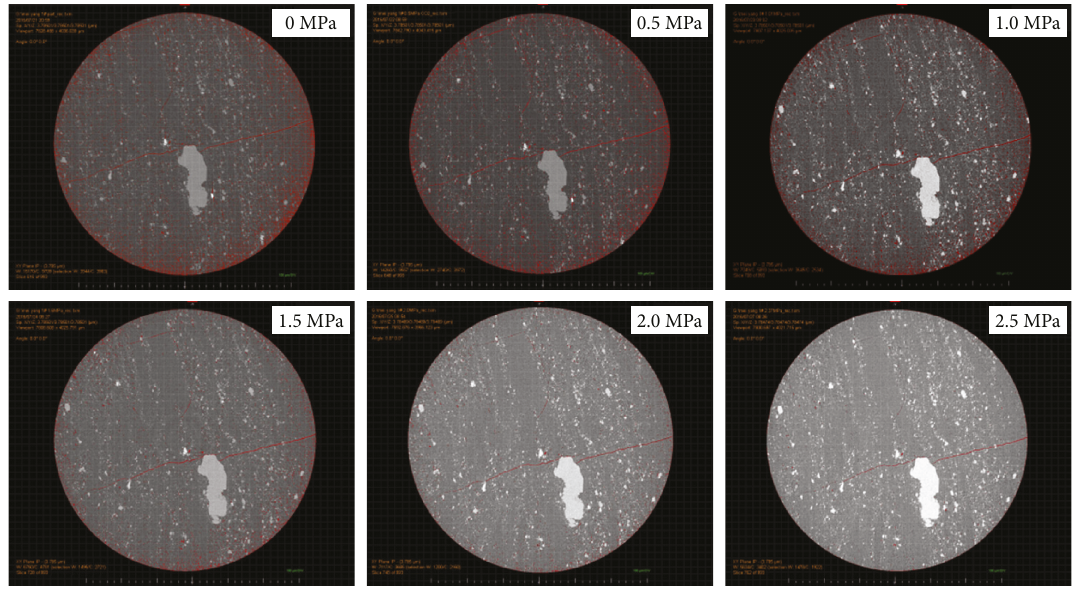
Figure 16: CT images of coal under di ff erent adsorption